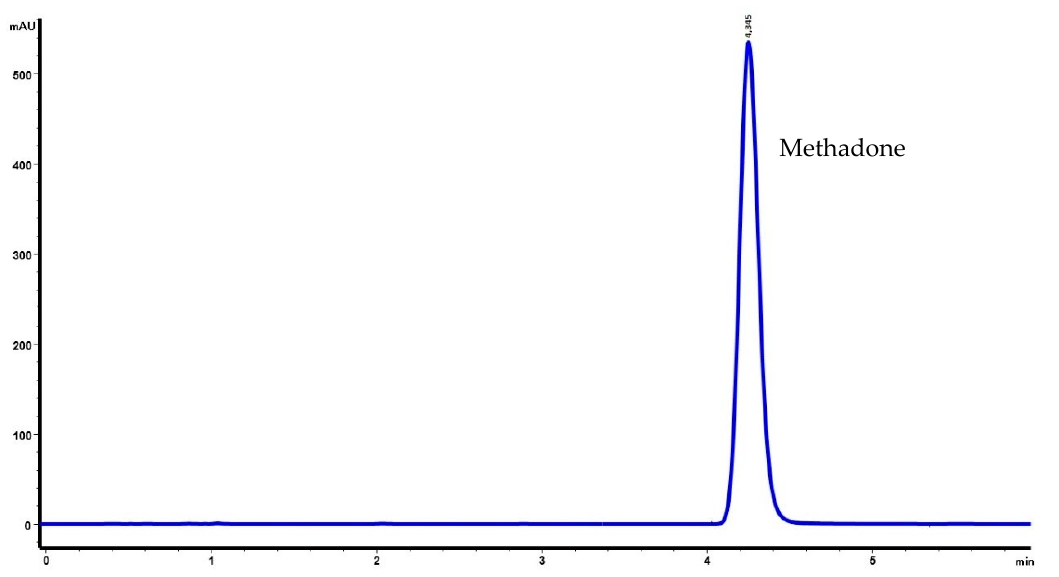
Figure 1. Chromatogram of methadone hydrochloride (10 mg/mL) without preservatives (M1). Retention time for methadone was 4.345